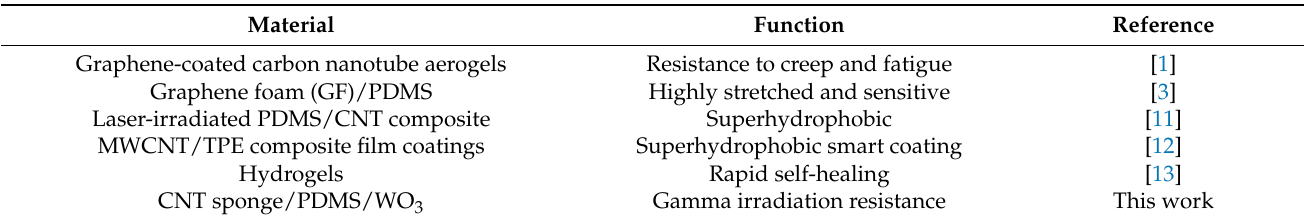
Table 1. Multifunctional flexible stress sensing